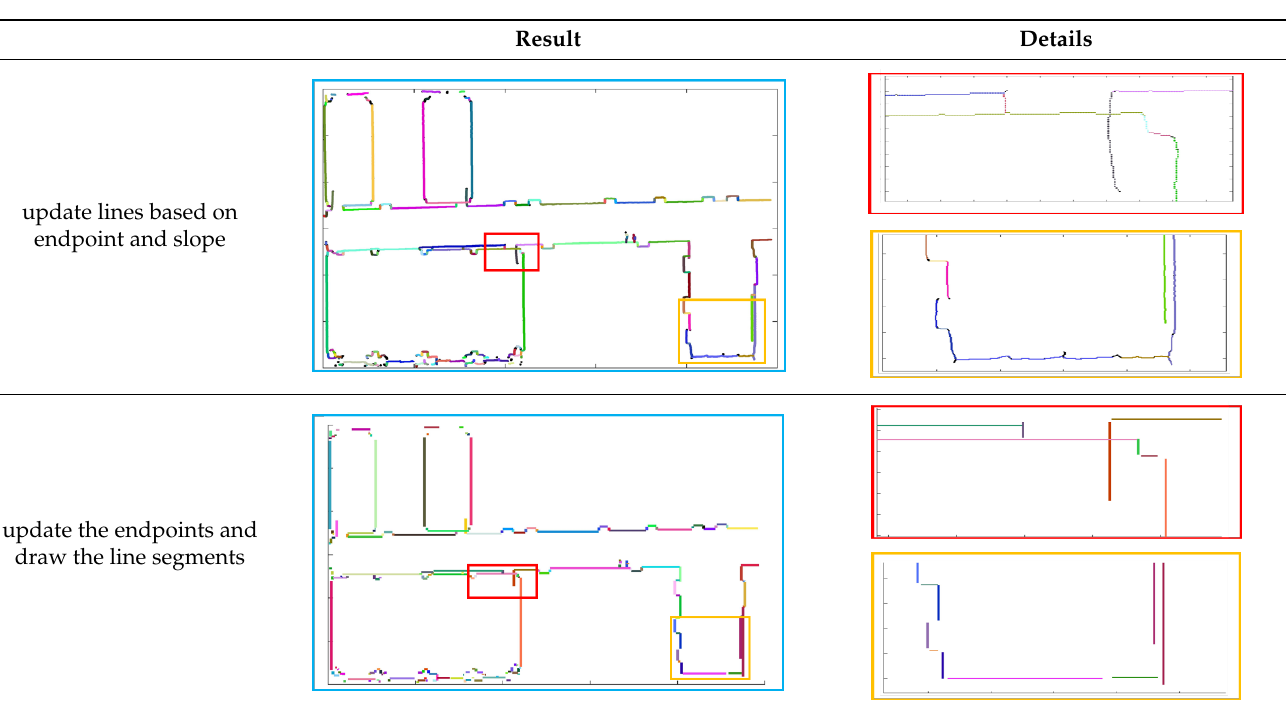
Figure 18. The result of line correction. All the lines that satisfy the condition are connected and we show them in detail.